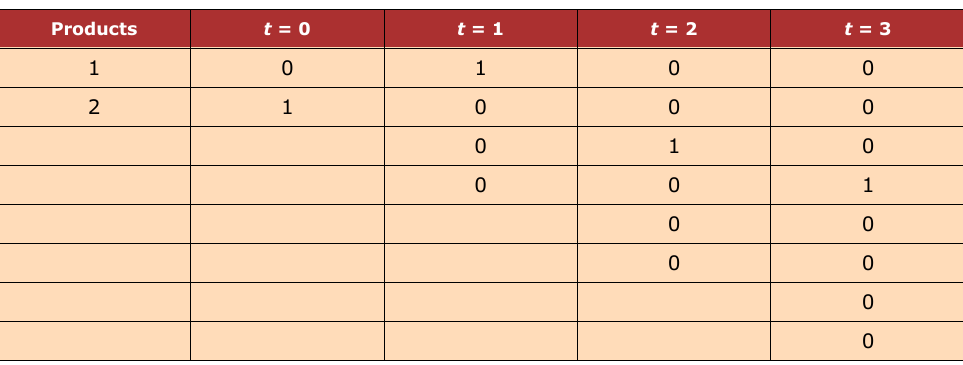
Table 6. Production Timing for the Optimal